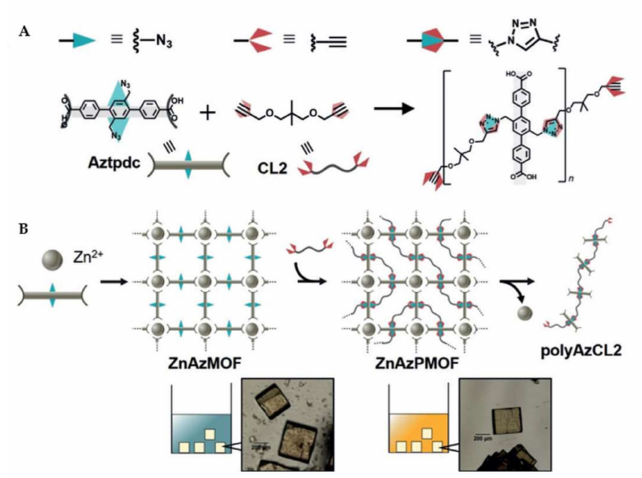
Figure 15. ( A ) Scheme showing the polymerization of Aztpdc and CL2 by the azide–alkyne click reaction. ( B ) Scheme showing the polymerization of Aztpdc and CL2 in ZnAzMOF to obtain linear polymer. The appearance of ZnAzMOF (left) and ZnAzPMOF (right) by optical microscopy images [94]. Copyright 2019 by John Wiley & Sons, Inc.